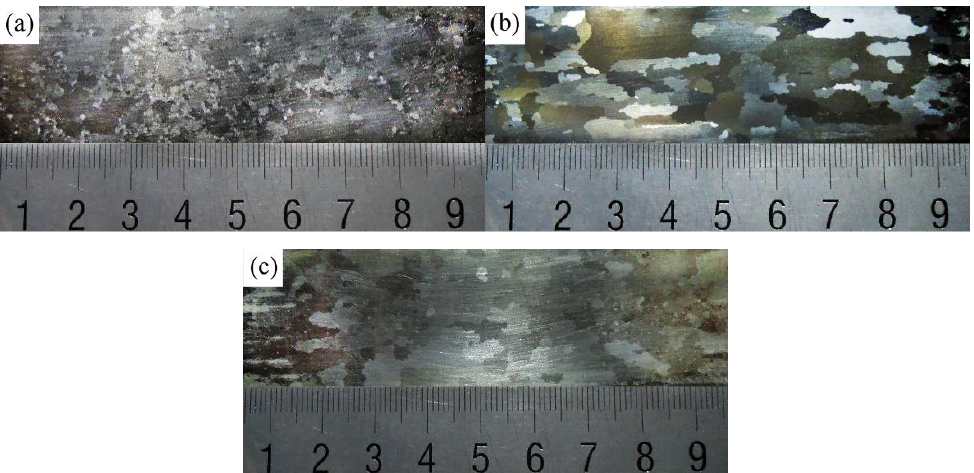
Figure 7. Macrostructure after high-temperature annealing with different decarbonization annealing times of ( a ) 3 min, ( b ) 5 min and ( c ) 7 min.